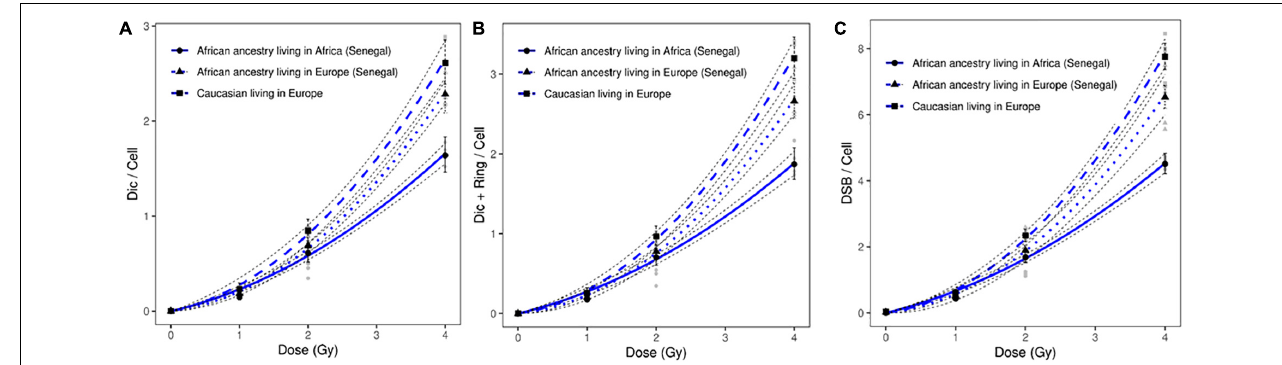
FIGURE 4 | Dose response curves obtained after X-ray irradiation of circulating lymphocytes in vitro of healthy donors of African ancestry living in Africa (Senegal), healthy donors of African ancestry (Senegal) living in Europe, and European ancestry living in Europe after scoring of (A) dicentric chromosomes, (B) dicentric and ring chromosomes, and (C) calculated DSBs. The mean numbers of chromosomal aberrations with 95% confidence intervals of each population are shown. Individual values for each of the donors are also plotted, as well as the standard errors (dotted